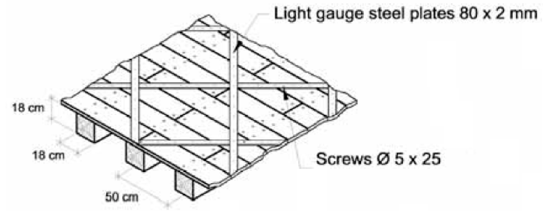
Figure 31. Reinforcement of timber floor: two layers of wood boards can be added over a pre-existing timber beam floor. The use of stainless inclined steel screws to connect the boards to the beams may highly increase both flexural and in-plane stiffnesses. Reproduced from [80], with permission from Elsevier, 2015.